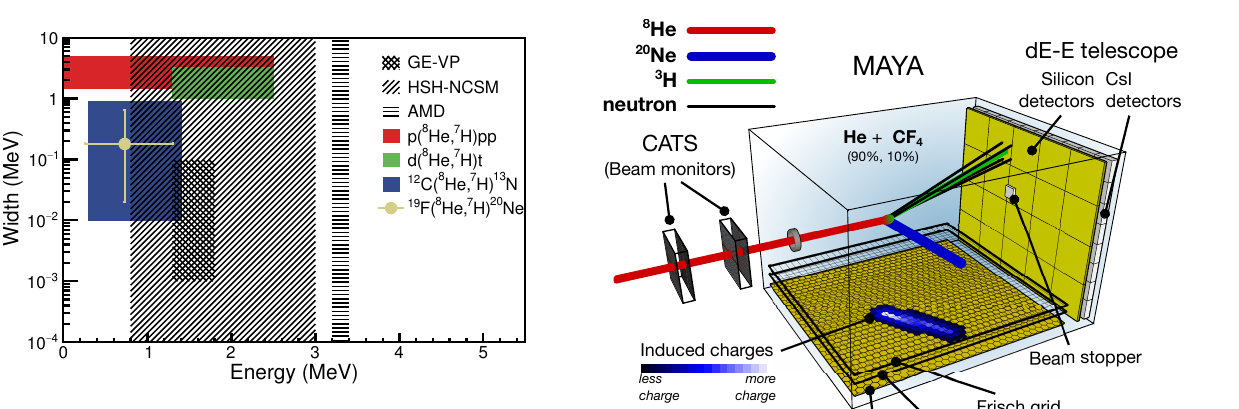
Figure 1. Summary of theoretical and experimental results on 7 H. Hatched areas correspond to predicted width and mass val- ues from Gaussian emission o ff of a Volkov Potential (dou- ble hatching, GE-VP) [8], Hyper-Spherical Harmonics with No- Core Shell Model (tilted hatching, HSH-NCSM) [7], and Anti- symmetrized Molecular Dynamics (horizontal hatching, AMD) [2]. The colour regions correspond to experimental results from p( 8 He, 7 H)pp knockout (red) [4], d( 8 He, 7 H)t (green) [5], and 12 C( 8 He, 7 H) 13 N (blue) [6]. The gold point corresponds to the present experiment.